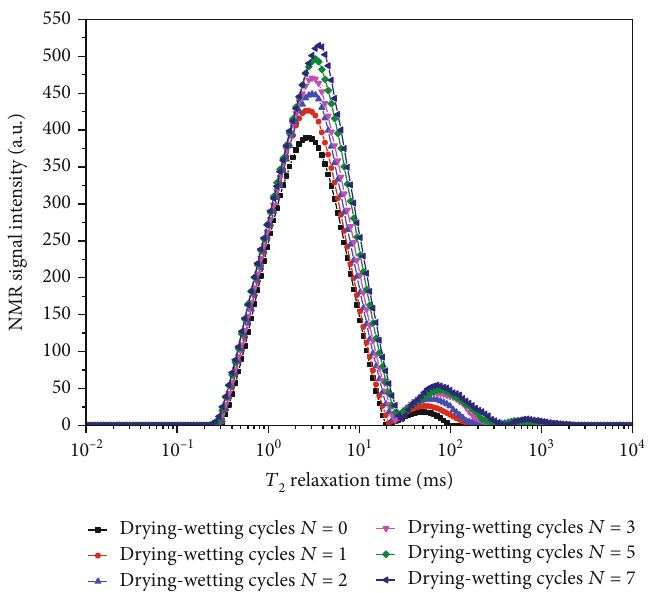
ff erent drying – wetting